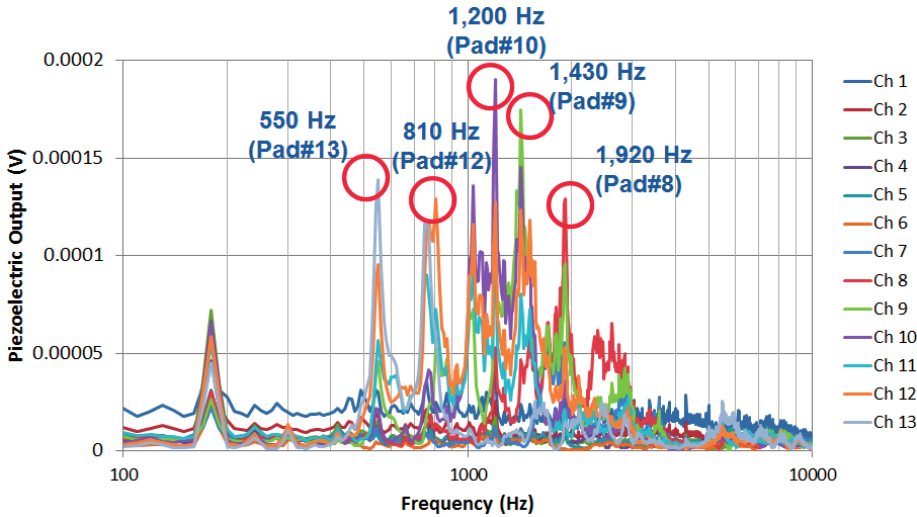
Figure 11. Electric signal outputs of the designed